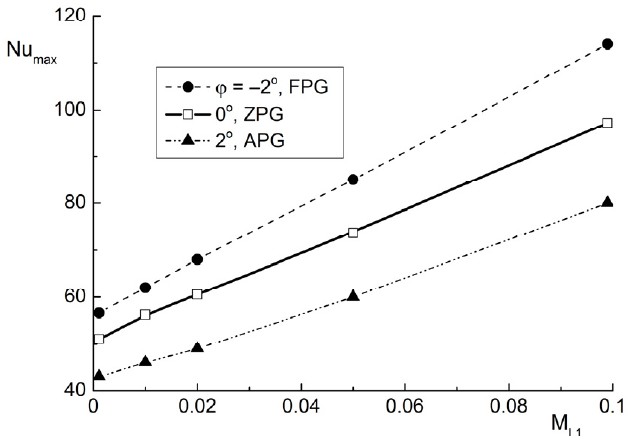
Figure 8. The magnitude of maximal heat transfer in the diffuser ( φ = 2°), confuser ( φ = − 2°) and separated flow ( φ = 0°) vs water droplets mass concentration. d 1 = 30 μ m.